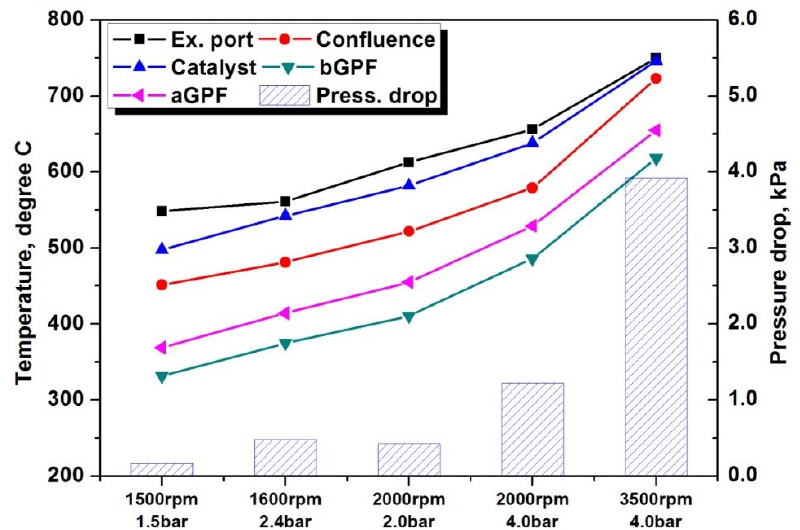
Figure 3. Exhaust system temperatures and pressure drop of GPF in various part-load conditions; (start of injection (SOI), 300°–304° CA before top dead center (BTDC); Lambda = 1.0; spark advance (SA) = minimum spark advance for the best torque (MBT)).